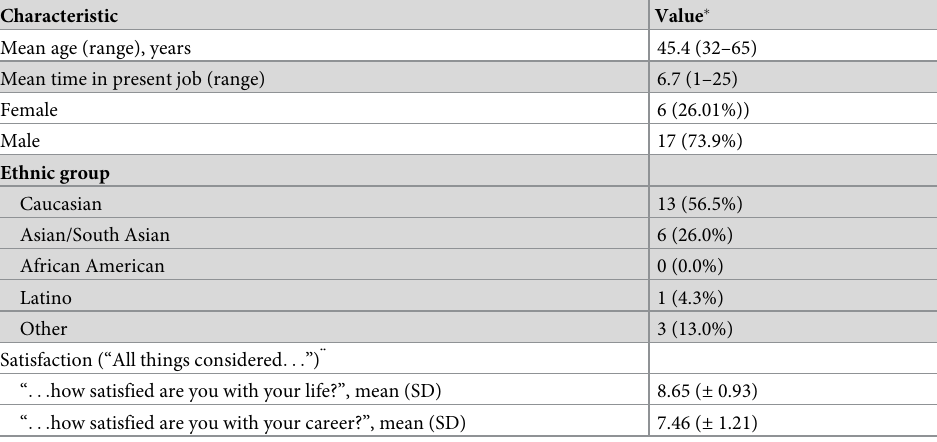
Table 1. Characteristics of study participants (n =